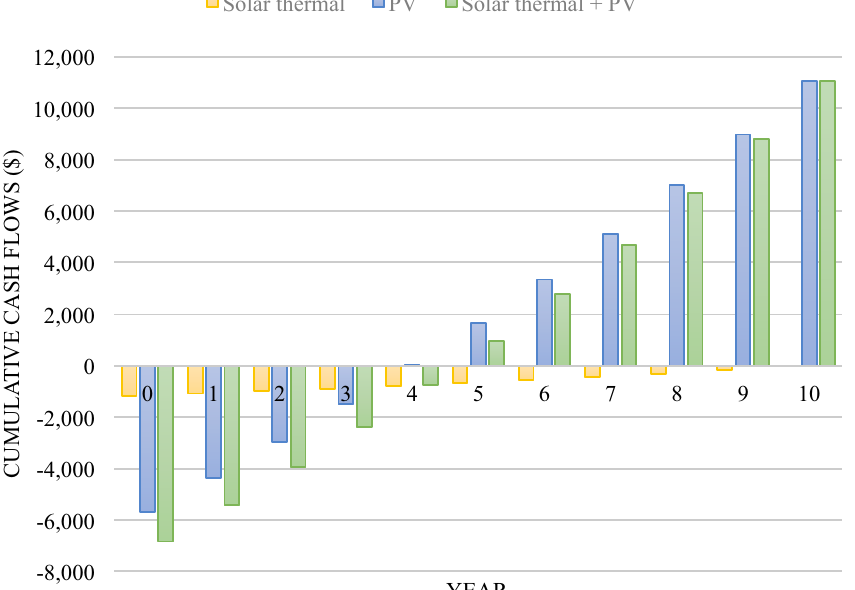
Fig. 4. Cumulative cash fl ows for the heating part (solar thermal), electricity part (PV), and solar